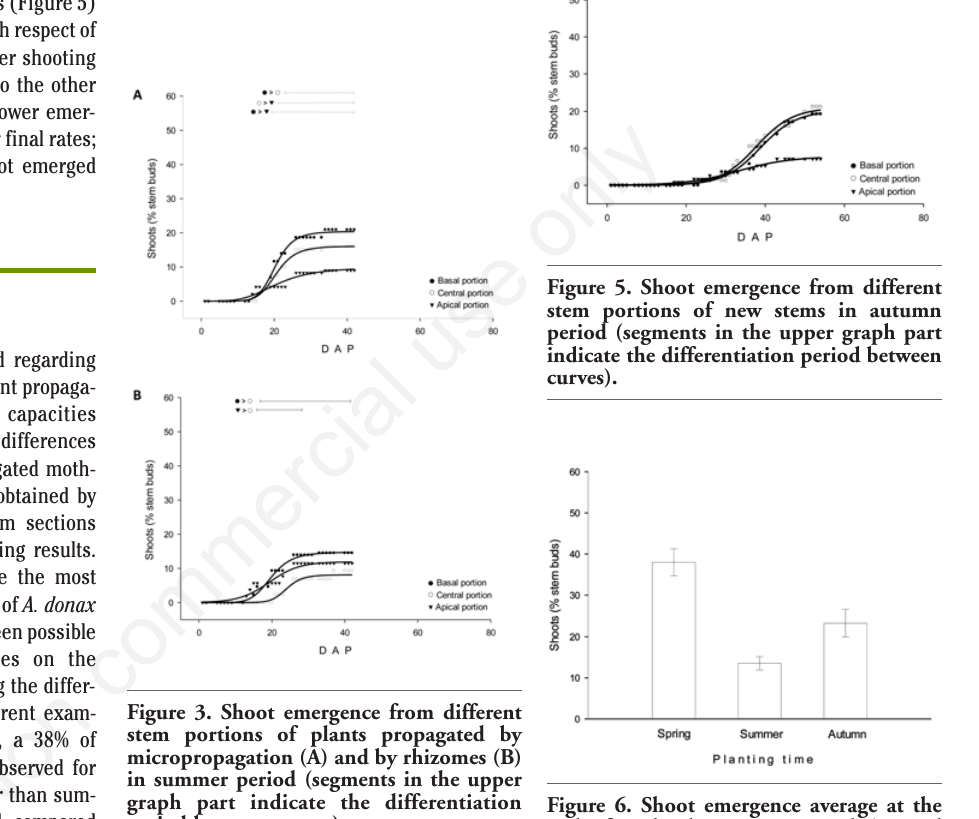
Figure 6. Shoot emergence average at the end of each observation period (vertical bar = standard error).